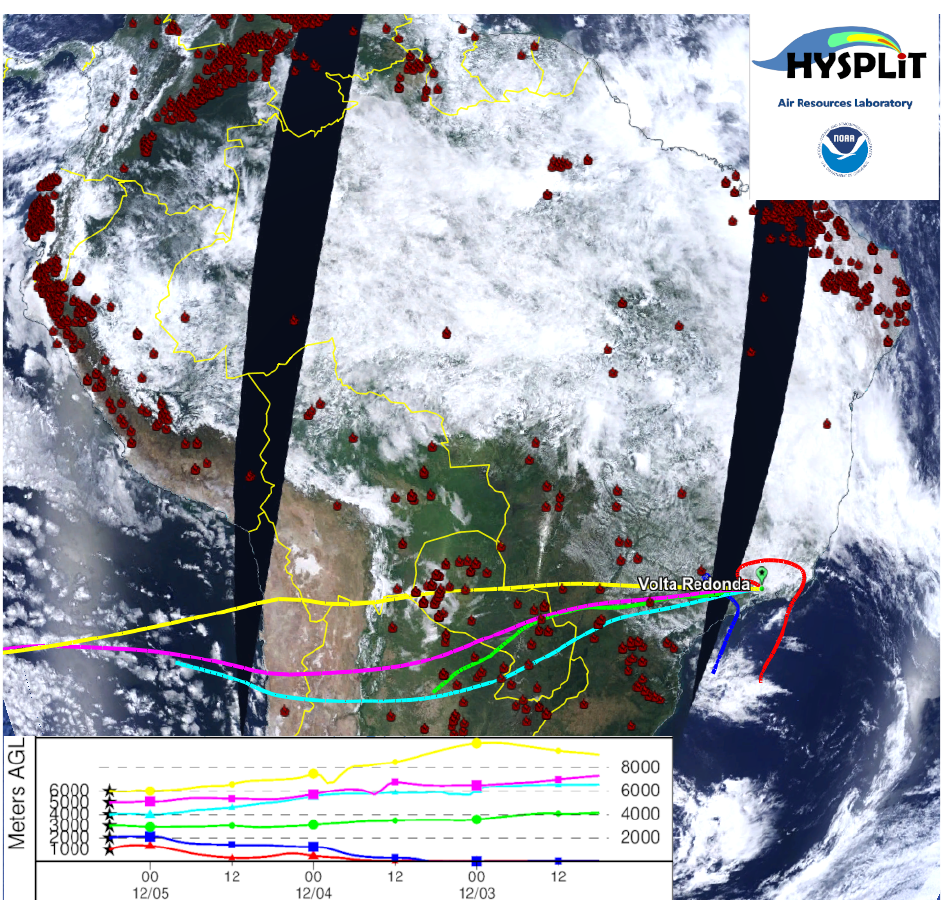
Figure 11. Three-day backward trajectories ending at Volta Redonda site with different altitude levels, from 1000 to 6000 m a.g.l., on 5 December of 2018 at 06:00 UTC. Several fire focuses, represented by the red points, are detected by AQUA MODIS and retrieved from the biomass burning database from the National Institute for Space Research (INPE)—http://queimadas.dgi.inpe.br/queimadas/portal (accessed on 17 September